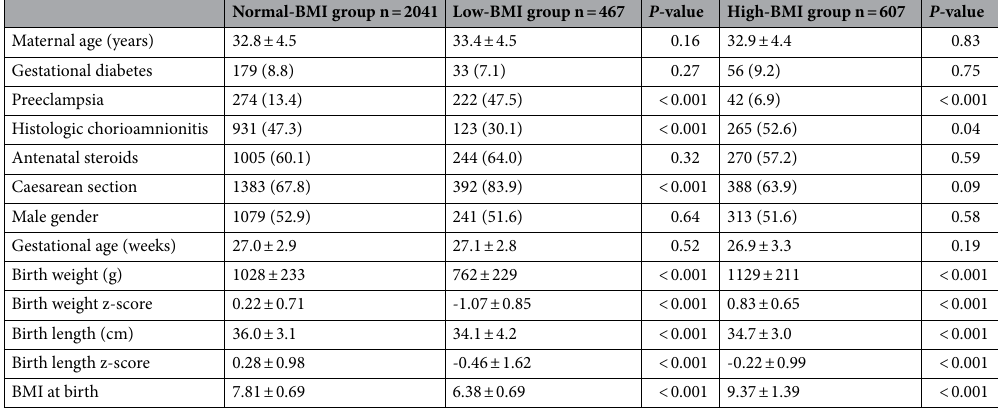
Table 1. Baseline characteristics of each BMI group. Data are expressed as n (%), mean ±